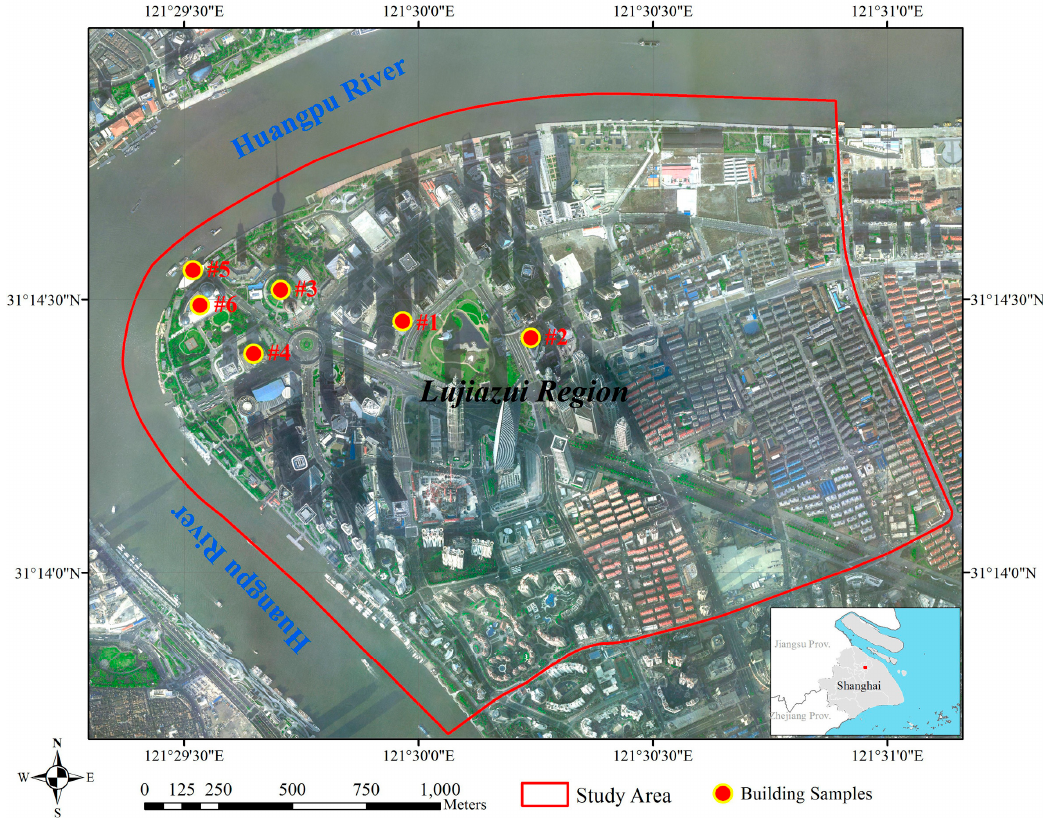
Figure 4. Geographical location and high-resolution aerial photograph of the Lujiazui region in Shanghai, China.